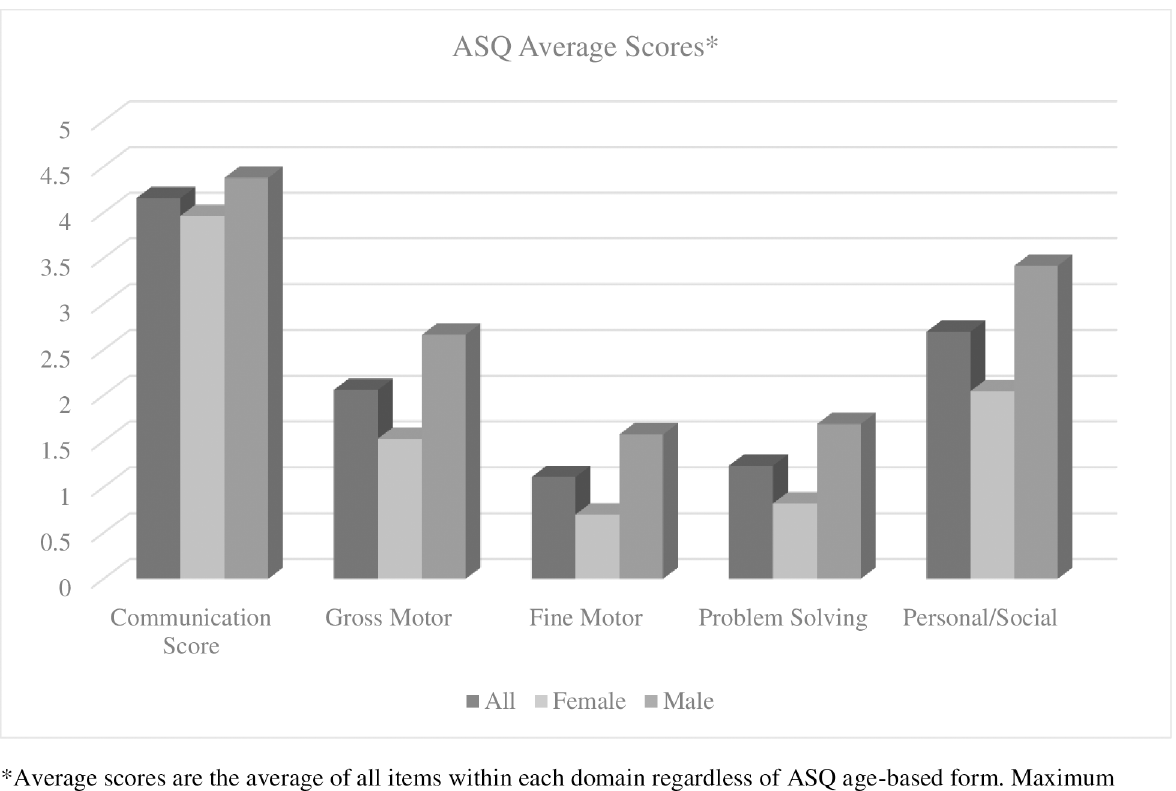
Fig 1. Average scores on ASQ domains by